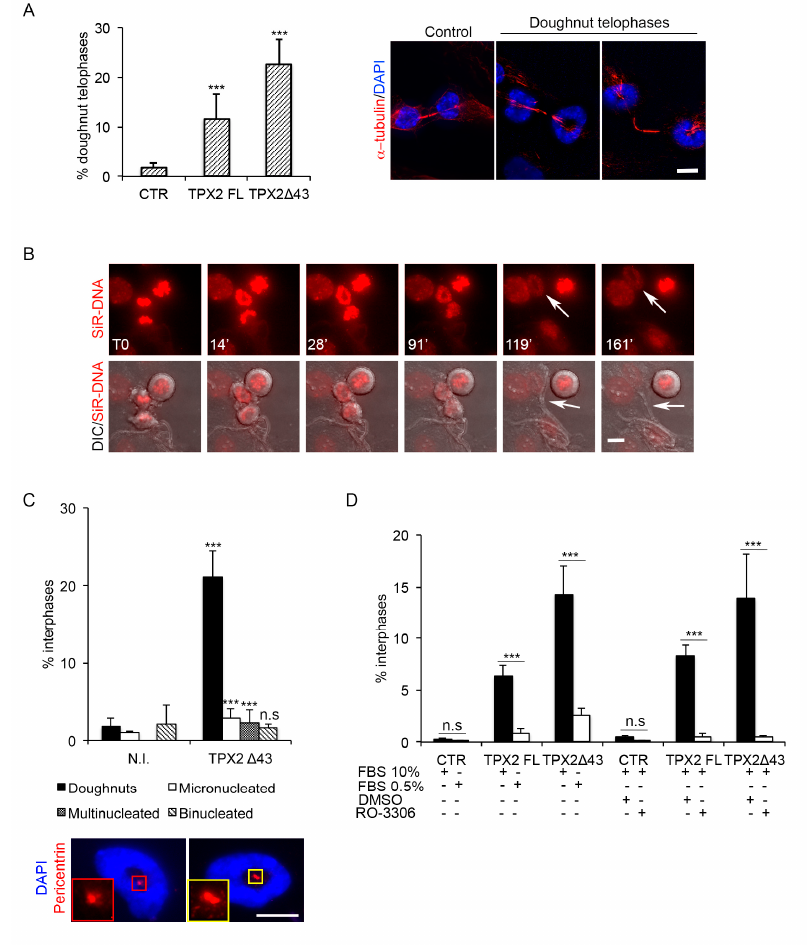
Figure 5. Doughnut-shaped nuclei formation requires passage through telophase. ( A ) Telophase cells with doughnut-shaped reforming nuclei, shown in the IF panels, appear in the indicated cell lines, as quantified in the histograms on the left (12 h induction). ( B ) Generation of doughnut-shaped nuclei in telophase was recorded by time lapse microscopy in the FLAG-TPX2 Δ 43 cell line not overexpressing VENUS (see Supplementary Figure S2); chromosomes are in red (SiR-DNA fluorescent label) and DIC images are merged in the lower panels. The first recorded telophase frame is indicated as T0. White arrows in the upper panels indicate the forming doughnut, while those in the lower panels indicate the intercellular bridge. ( C ) The percentage of defective interphases after mitotic shake off/re-plate in TPX2 Δ 43 -overexpressing cultures (or non-induced controls, N.I.) is indicated in the histograms. The cell line with no VENUS expression (see Supplementary Figure S2) was used, in order to label centrosomes with anti-pericentrin antibodies, in addition to the DAPI and α -tubulin staining. The IF panels show examples of doughnut-shaped nuclei (DAPI) associated with one (left) or two (right) pericentrin spots (red); the insets show enlargements of the centrosomes. ( D ) Reduction of the doughnut-shaped nuclei phenotype was observed following serum starvation or RO-3306 treatment, in the indicated cell lines ( + and − indicate, respectively, the presence or absence of specific cell culturing conditions / treatments). Schematic representations of the experimental protocols are shown in Supplementary Figure S4. For all histograms, at least 1500 interphases per condition were analysed, from three independent experiments; s.d. are shown; *** p < 0.0001, n.s. (not significant) p ≥ 0.05, chi-square (and Fisher’s exact) test. Scale bars: 10 µ